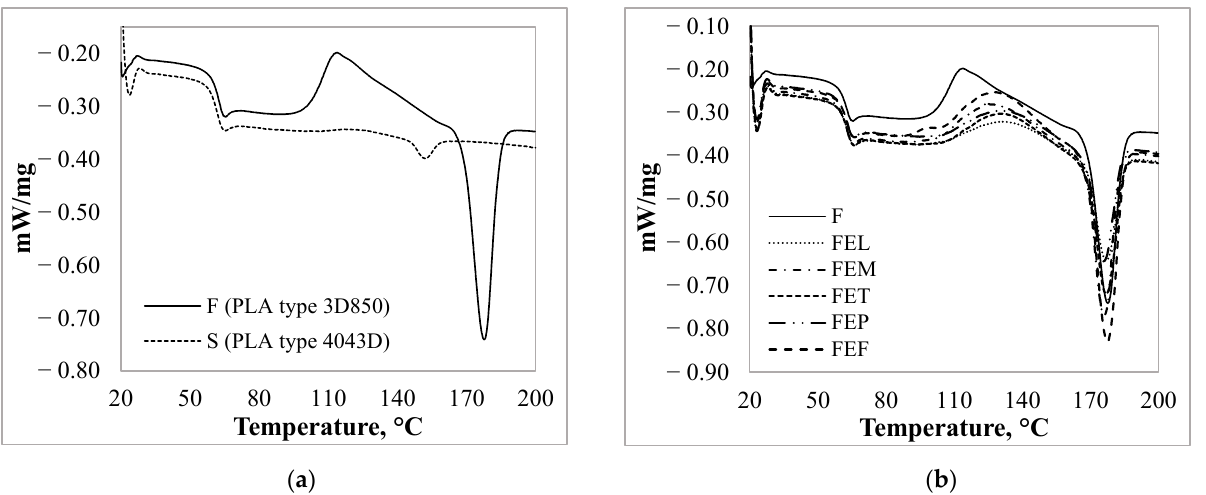
Figure 9. DSC thermograms of the samples: ( a ) DSC curves of the two PLA granules, ( b ) DSC curves of 3D850 PLA granules after adsorption.